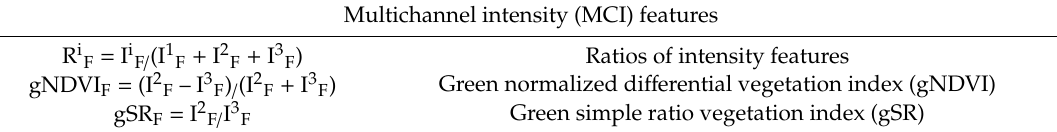
Table 4. List of all features derived from spectral information of the laser returns Superscripts (i) 1, 2, and 3 represent channel numbers and subscript F refers to single-channel intensity feature used.